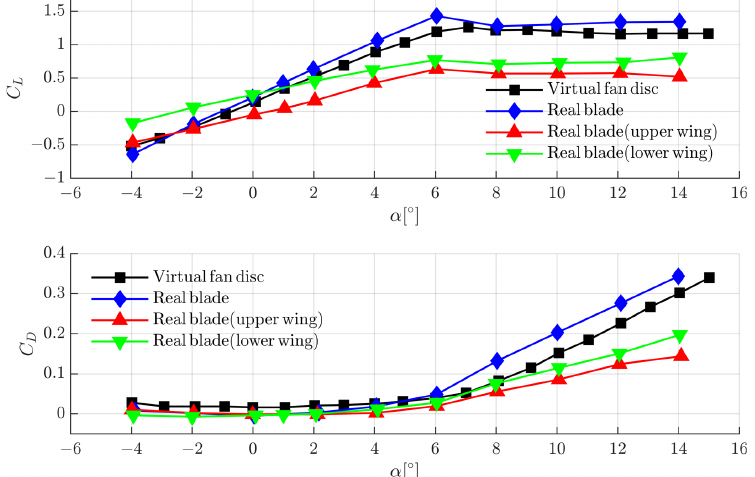
Figure 19. The comparison between the DFW unit simulation using the real blade and virtual disc with momentum sources. ( Upper ) Lift coefficient comparison; ( Lower ) Drag coefficient comparison. In the DFW vertical meridional plane simulation, the 2D fan boundary is adopted to represent the pressure step generated by the ducted fan between the upper and lower